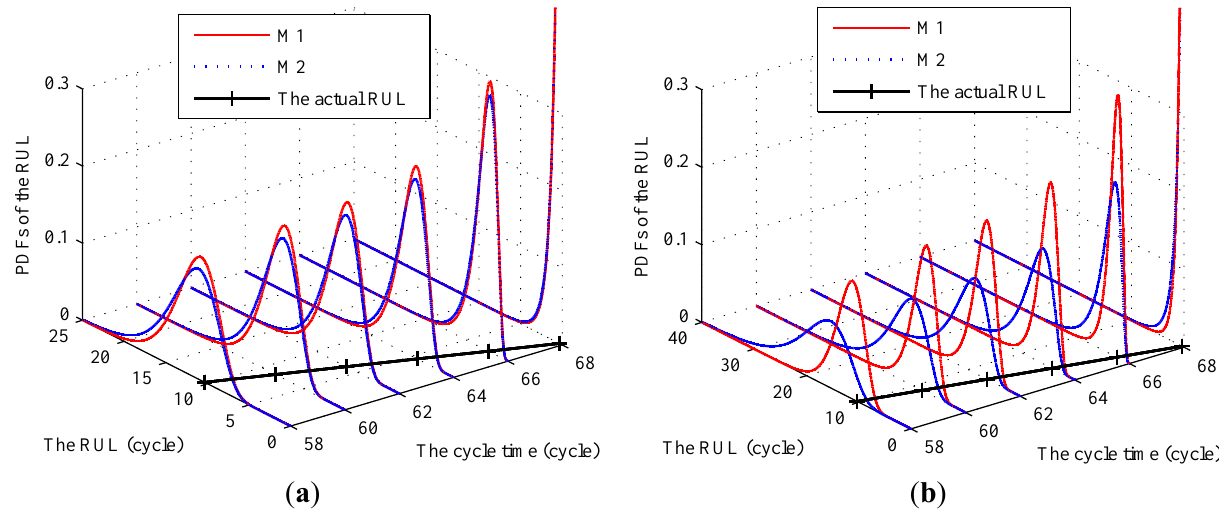
Figure 7. The PDFs of the RULs at different times. ( a ) right prior information; and ( b ) inappropriate prior